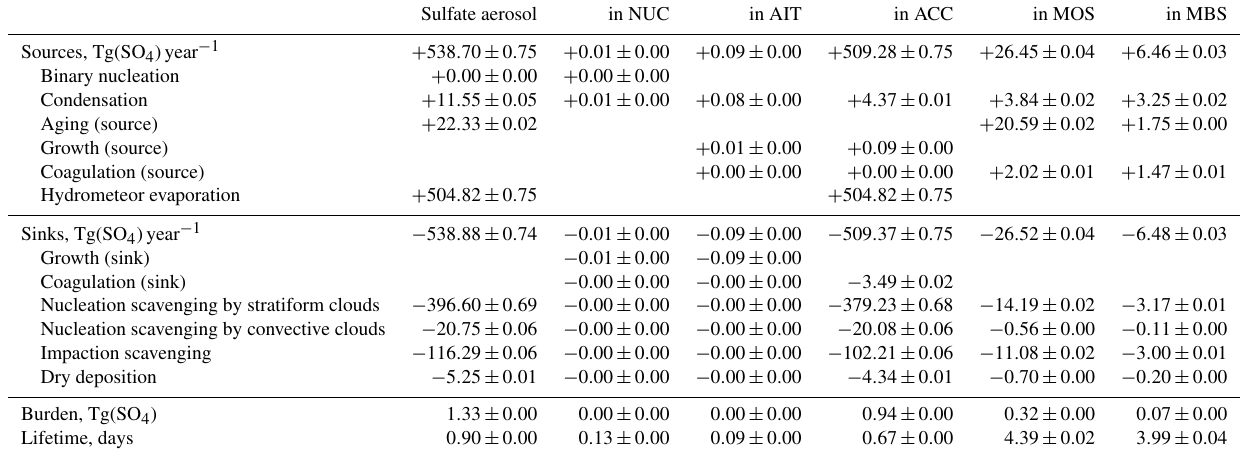
Table 1. Global mass budgets and lifetimes of sulfate aerosol for the year-2000 MARC simulation, showing values for total sulfate aerosol and sulfate aerosol in each mode. Negative values indicate sinks. Standard errors are calculated using the annual global total for each simulation year; for each lifetime (calculated as Burden divided by Sinks), the combined standard error is calculated following Hogan (2006). The processes acting as sources and sinks are summarised in Fig. 1a. Growth and coagulation transfer sulfate between modes but do not directly influence the total sulfate aerosol mass. Due to hydrometeor evaporation, scavenging does not necessarily result in permanent removal from the atmosphere in the form of wet deposition. (It is not possible to calculate the net wet deposition rate, because the aqueous oxidation of sulfur dioxide and scavenging of gas-phase sulfuric acid also contribute to the sulfate dissolved in the hydrometeors, as shown in Fig. 1a.) Corresponding results for the year-1850 MARC simulation are shown in Table